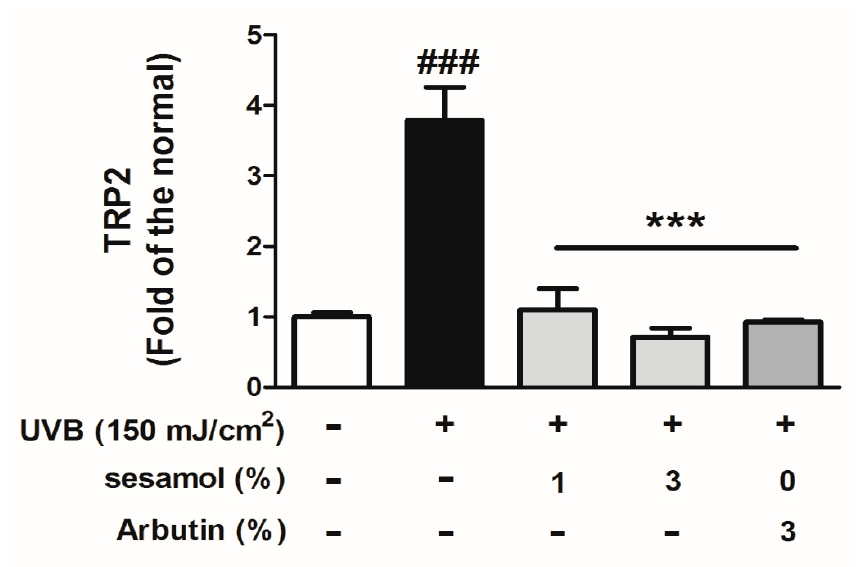
Figure 11. Light micrographs of histological sections stained with dopachrome tautomerase (TRP-2) in UVB-irradiated C57BL/6 mice that received topical application of sesamol once a day to the ear skin. The TRP-2 level increased in the UVB-irradiated group, whereas topical application of sesamol reduced the effect. (Significant difference versus control: ###, p < 0.001. Significant difference versus UVB treated group: ***, p < 0.001.).